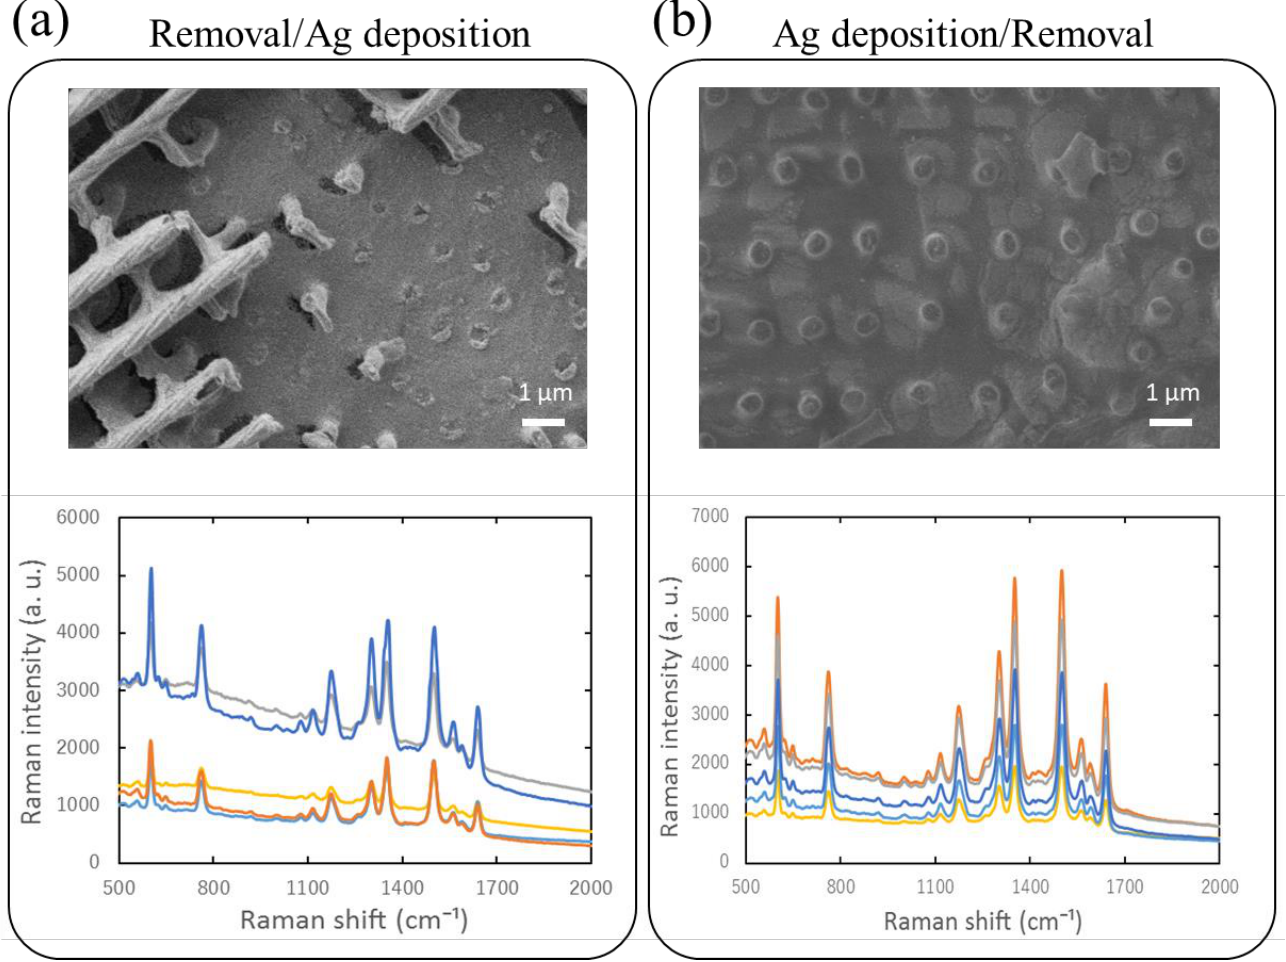
Figure 5. SEM images (Hitachi SU8030) of chestnut scales from S. charonda with the upper layer removed, ( a ) before and ( b ) after silver deposition. The SE-BSE mode was employed. SERS spectra of 1 mM R6G are shown below.